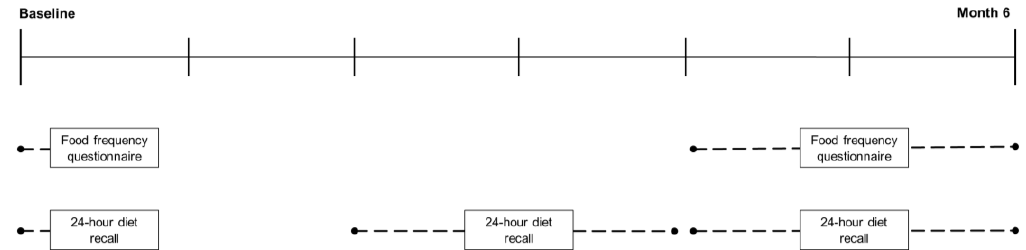
Figure 1. Implementation of study protocol to validate a food frequency questionnaire against 24-h diet recalls among children and adolescents in Lima, Peru.